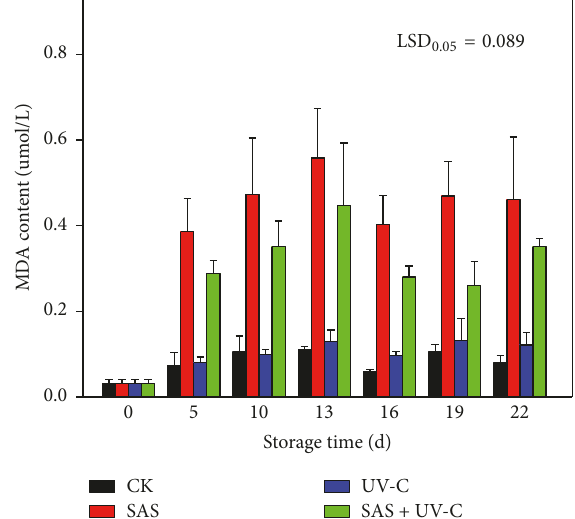
Figure 6: Effects of SAS, UV-C, and SAS + UV-C on MDA content of fresh-cut potatoes during storage. The error bars represent the standarddeviation.LSDsrepresentleastsignificantdifferencesatthe 0.05